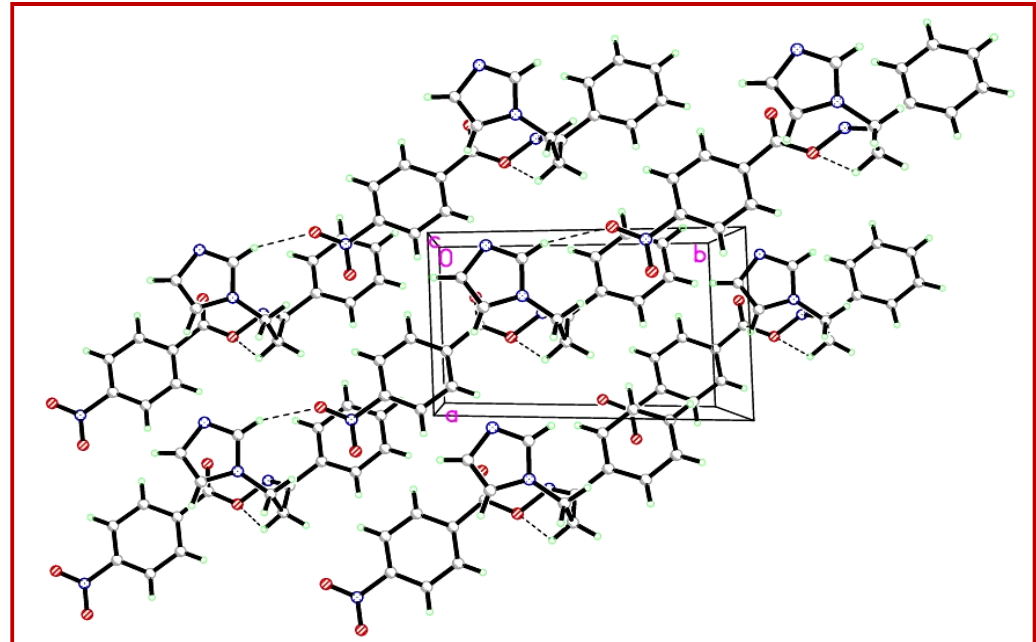
Figure 2: Crystal packing showing intermolecular C- H•••O hydrogen bonds as dashed lines